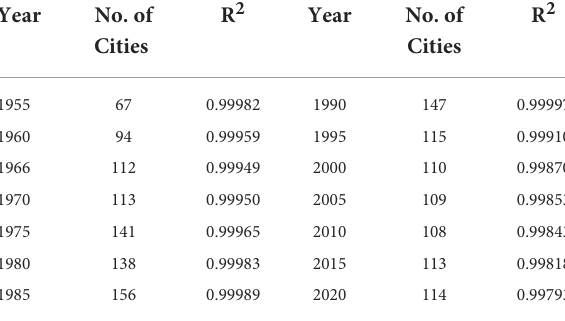
TABLE A1 Regression diagnostics for the rank-size estimations at the city level.